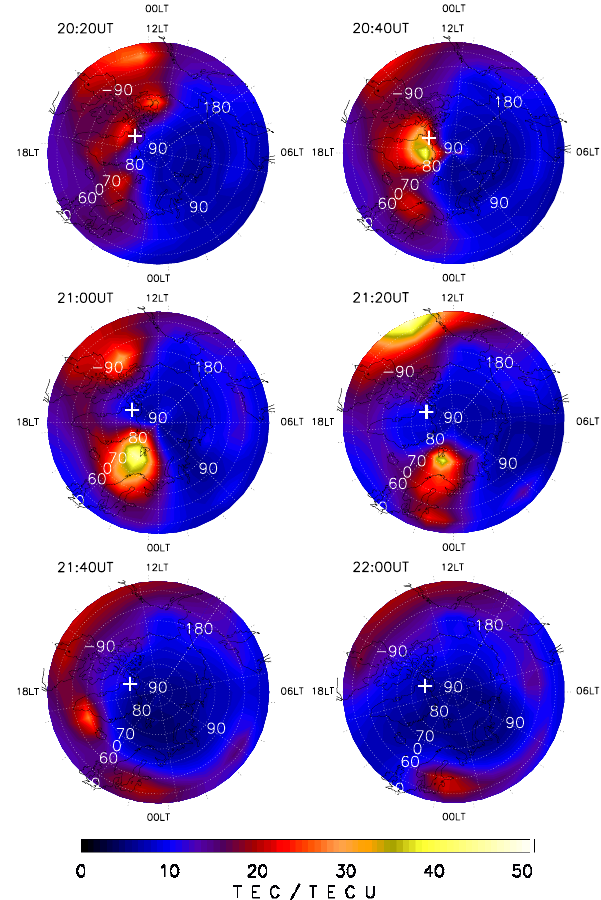
Fig. 3. Maps of vertical TEC re-integrated from north polar 3- D electron density fields obtained by the assimilation of IGS and SOPAC ground data for 30 October 2003. If a black cross is given right next to the map, CHAMP IRO data are also assimilated. Geo- graphic coordinates are displayed. The white plus sign indicates the location of the geomagnetic